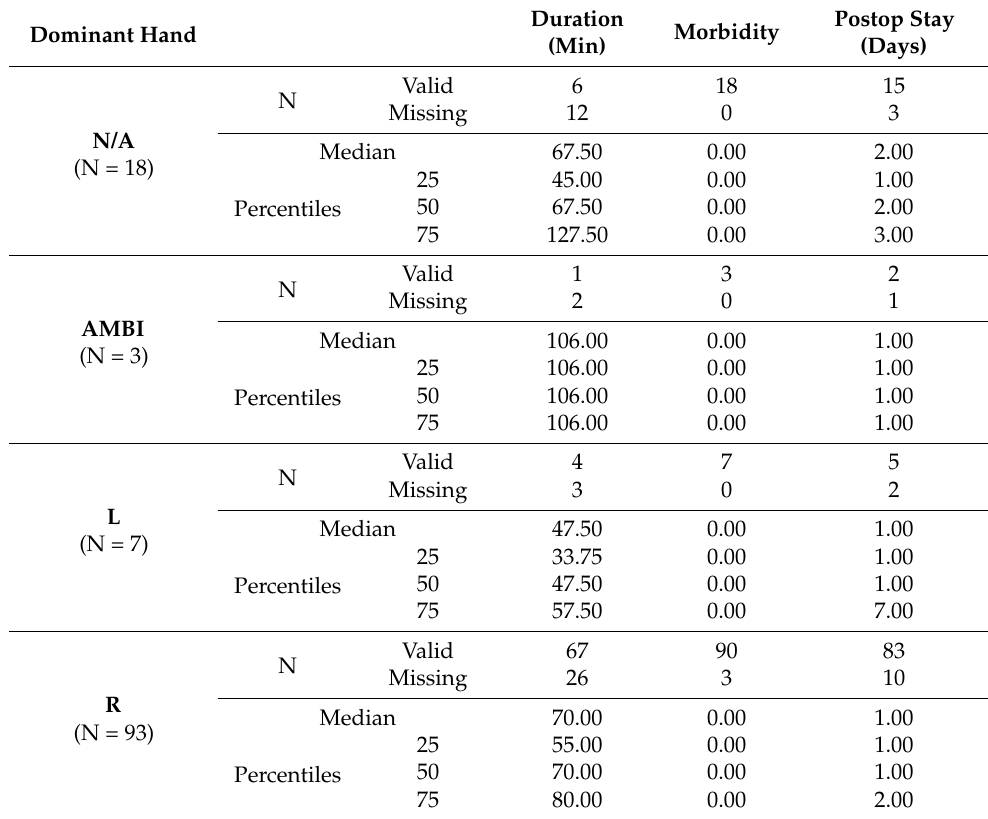
Table 5. Surgery duration, morbidity, and postoperative stay sorted by dominant hand of the surgeon. Dominant Hand